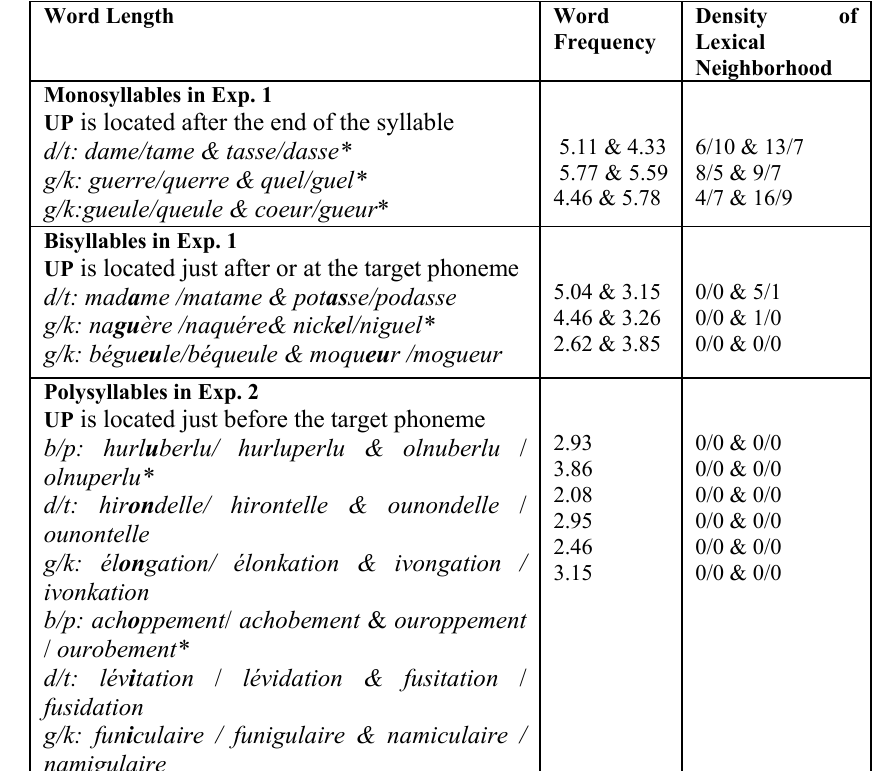
Table I: Endpoints of the stimulus continua used in the two experiments are presented in the first column. Target phonemes are presented first followed by word and nonword continua endpoints. UP locations are indicated in bold. Lexical frequencies of the word stimuli of the two experiments (in log10 x frequency units) are presented in the second column. Densities of lexical neighborhood are presented in the third column. Stars indicate significant (p < .05) lexical